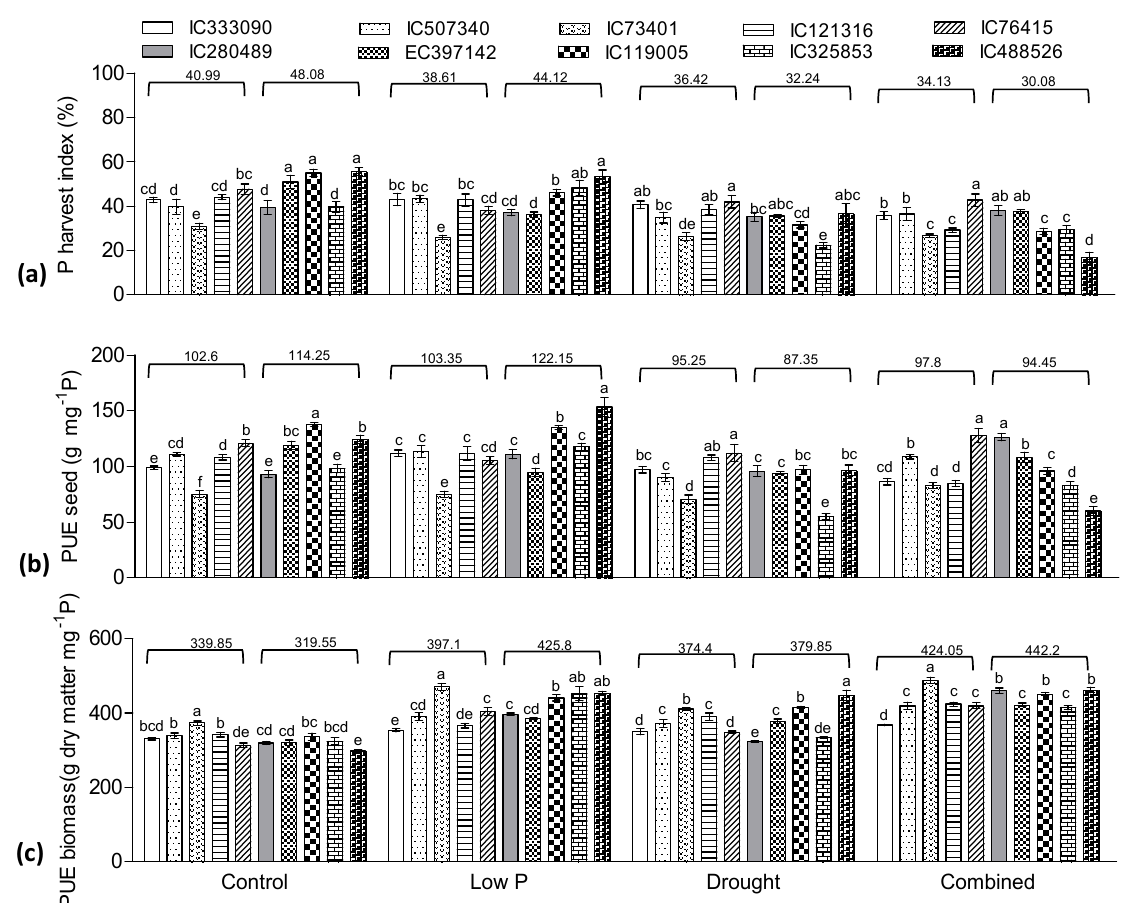
Figure 4. Effect of low P, drought, and combined stress on ( a ) P harvest index (%), ( b ) PUEg (g seed mg − 1 P), ( c ) PUEbm (g dry matter mg − 1 P) in 10 mung bean accessions. Values on bars 1–5 and 6–10 represents mean of tolerant and sensitive accessions, respectively. The letters on each bar denotes significant difference between accessions in each treatment. Error bars indicate mean ± SEm.